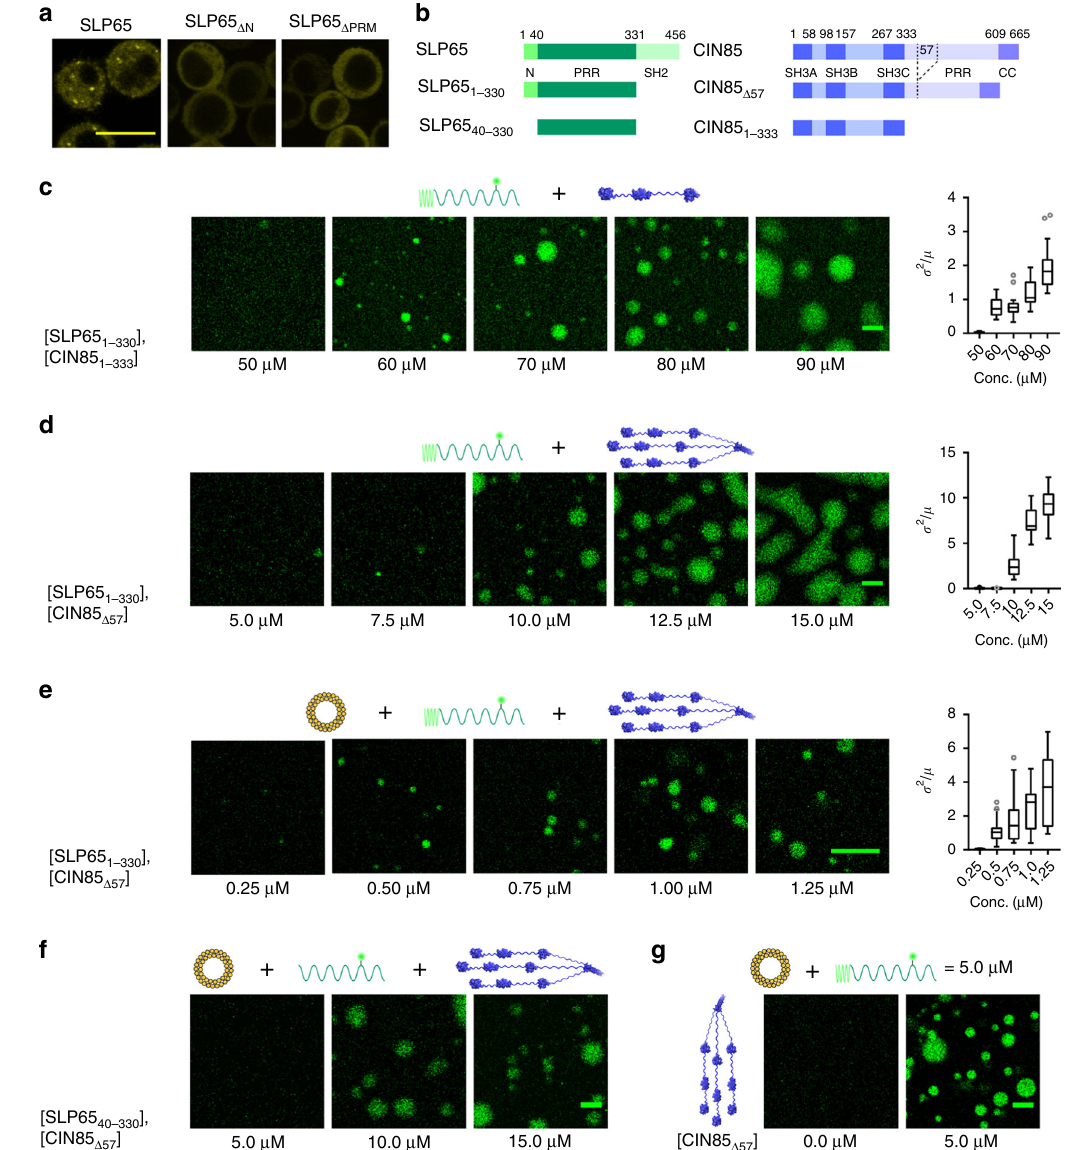
Fig. 1 Tripartite phase separation of SLP65 with CIN85 and SUVs. a Confocal fl uorescence microscopy of SLP65-de fi cient DT40 B cells that had been reconstituted with a citrine fusion protein of either wild-type SLP65 (left), a variant lacking N-terminal 45 amino acids ( Δ N, middle), or a CIN85 binding- de fi cient variant ( Δ PRM, right). b Domain architecture of the different constructs of SLP65 and CIN85 studied here (PRR: proline-rich region, CC: coiled coil). c – e Confocal fl uorescence microscopy of a mixture of different concentrations of Atto 430LS-tagged SLP65 1-330 with the corresponding equal concentrations of either ( c ) CIN85 1-333 , ( d ) CIN85 Δ 57 , or ( e ) CIN85 Δ 57 and SUVs made from 1 mM of phospholipids (see Method). The SUVs had a lipid composition of DOPC:DOPE:DOPS = 65:25:10 mol% and a mean hydrodynamic radius of 23 nm. Concentrations of CIN85 Δ 57 refer to the monomeric concentration. Index of dispersion of the fl uorescence intensity were shown as box-and-whisker plots (12 ROIs and two independent samples, n = 24). The line inside the box and the edges of the box correspond to the median, fi rst and third quartiles, respectively. The outliers with value ≥ 1.5 times the interquartile range away from the top or bottom of the box are denoted by circles. Source data are provided as a Source Data fi le. f Different concentrations of Atto 430LS-tagged SLP65 40-330 were mixed with the corresponding equal concentrations of CIN85 Δ 57 together with 1 mM of SUVs. g Mixture of 5 μ M of Atto 430LS-tagged SLP65 1-330 and 1 mM of SUVs without CIN85 (left) or with 5 μ M of CIN85 Δ 57 (right). Scale bars equal to 10 μ m ( a , c – g